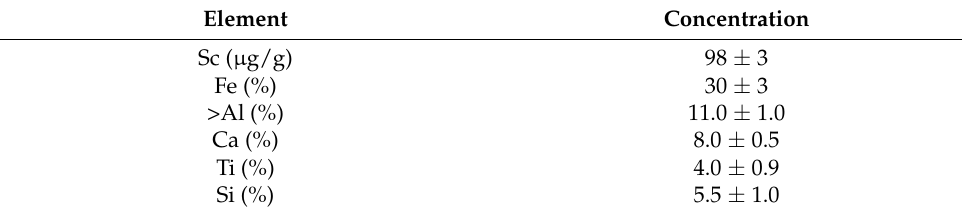
Table 1. Chemical composition of bauxite residue (BR) batch used in this study. Element